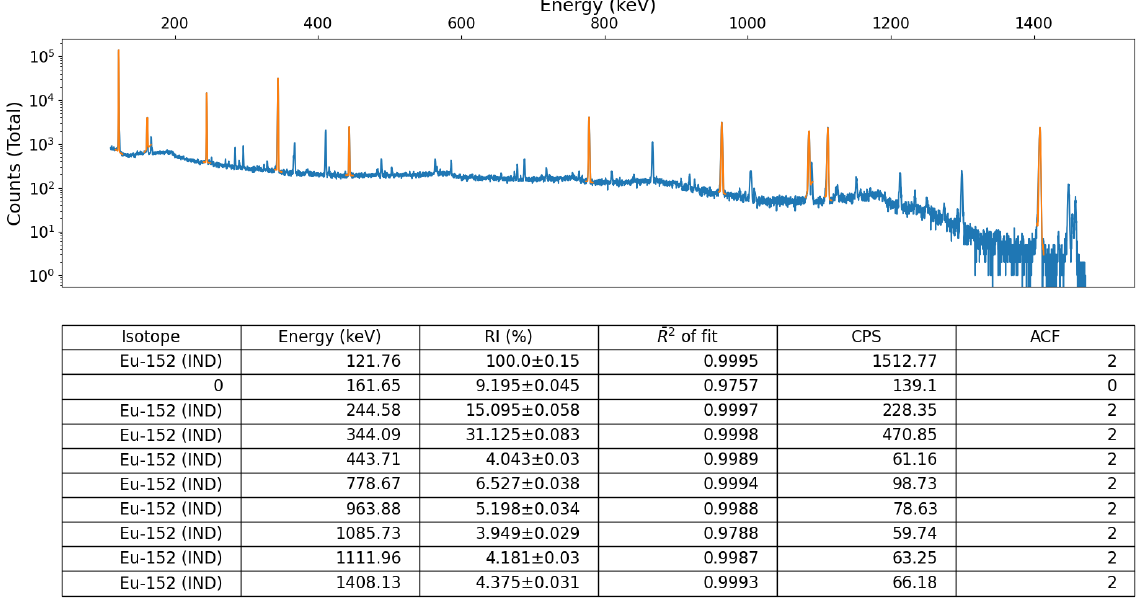
Figure 10. Peak-identified gamma-ray spectrum with counts on a log scale, analysed after data collection (post-processed), for a Eu-152 source obtained using a SAGe™ Well detector. The table comprises the same nomenclature as detailed formerly in Figure 5 The duration of data collection was 5 min (real-time).